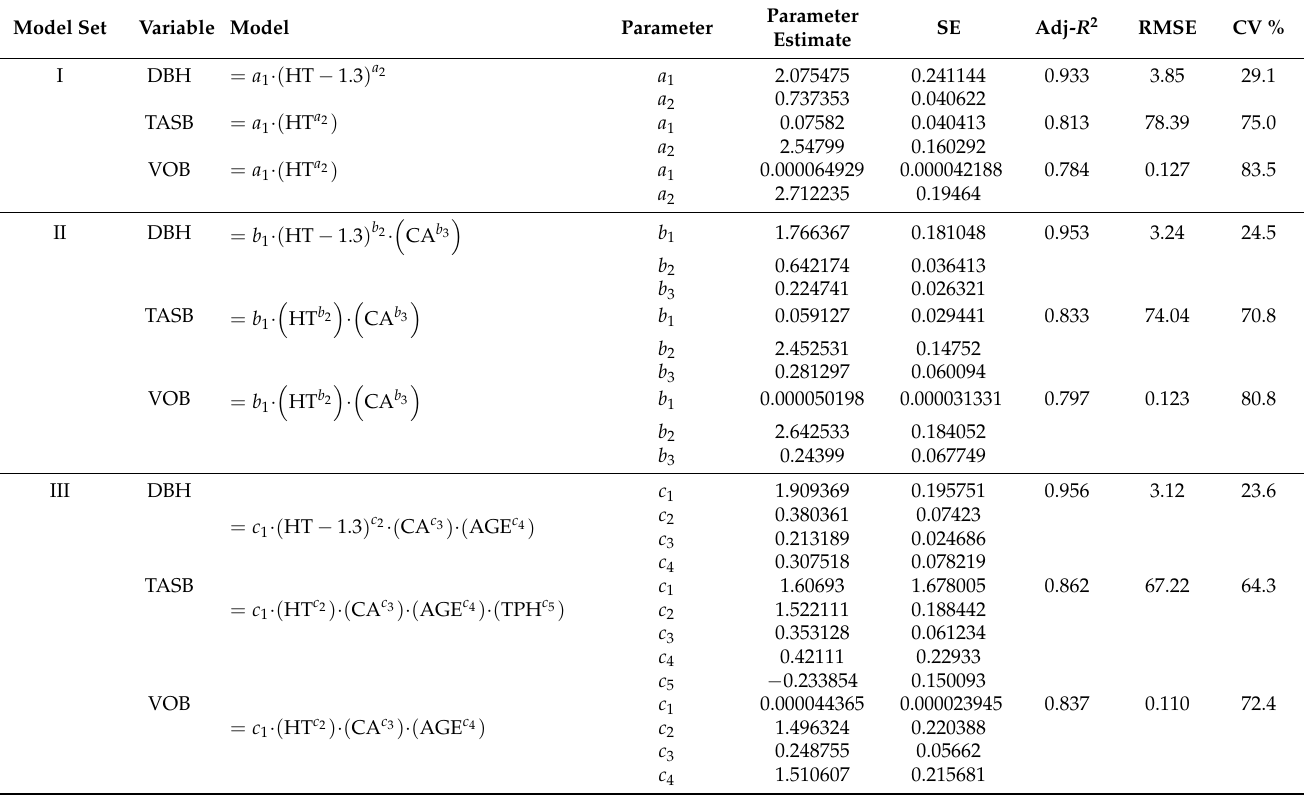
Table 2. Parameter estimates and fit statistics of the selected general DBH/biomass/volume functions for E. globulus trees growing in Central Chile.